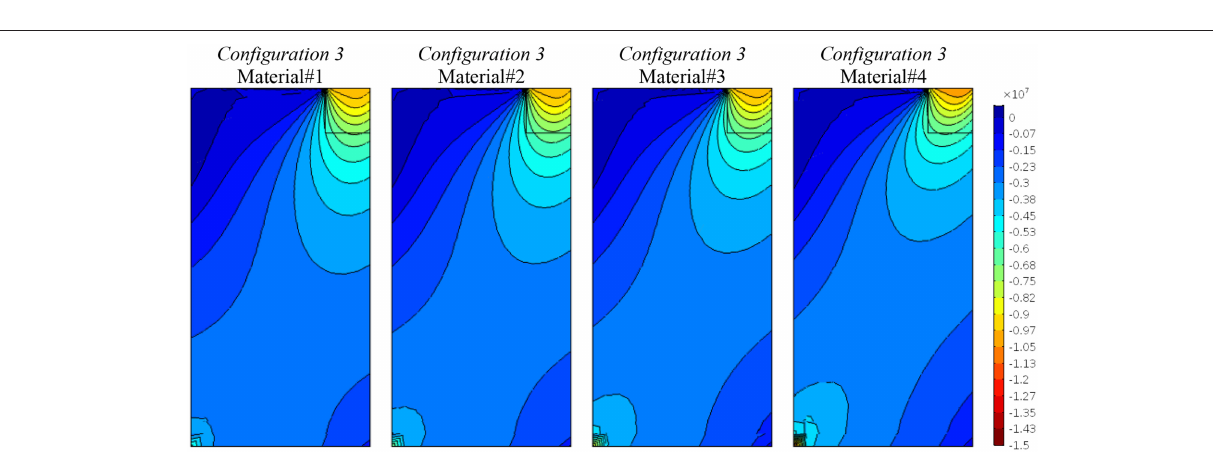
A 1122 = A 2211 and D 12 = D 21 , respectively concerns the classical “Poisson effect” and a corresponding micropolar out-of-diagonal effect in the model. The values provided are listed in Table 3